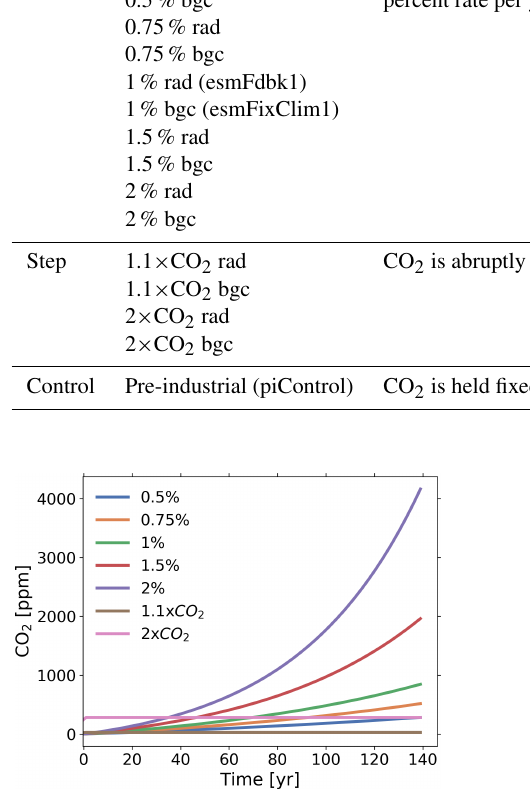
Figure 1. Forcings for the C 4 MIP-type experiments considered in this